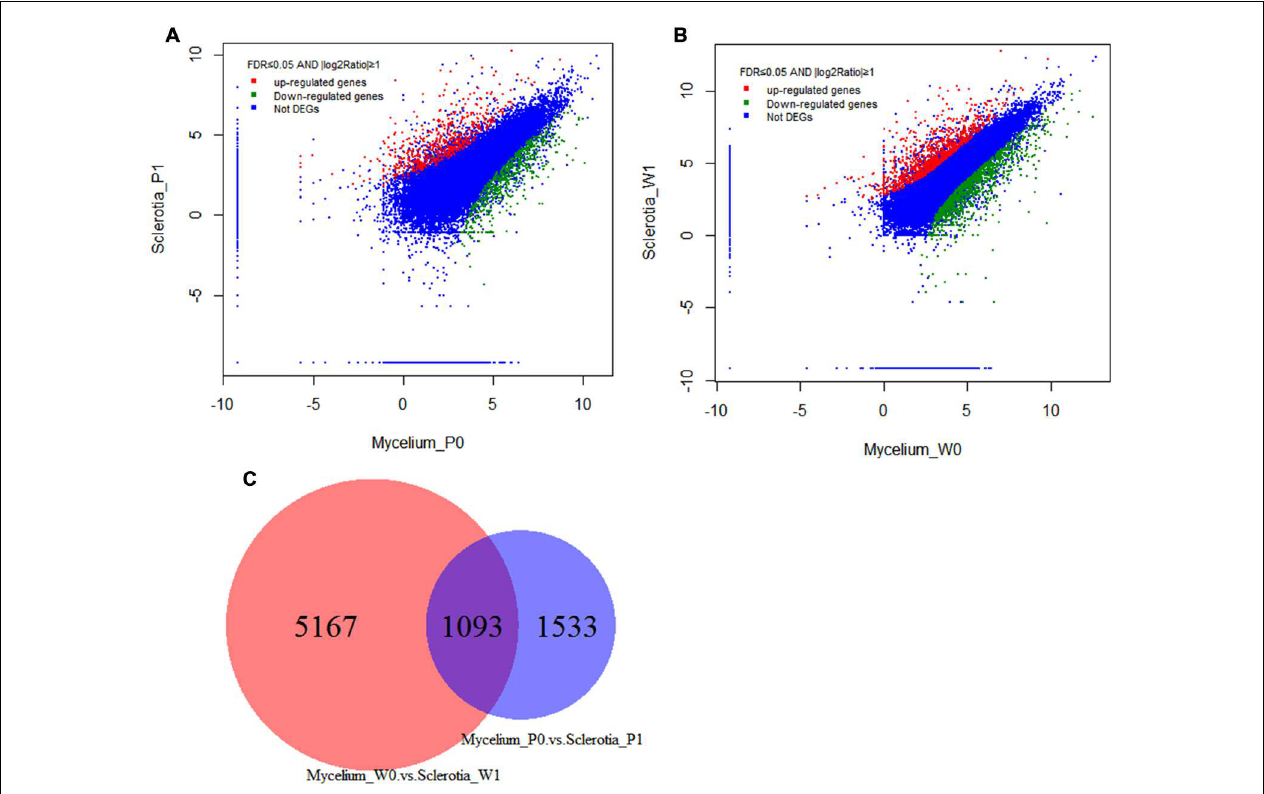
FIGURE 5 | Gene transcription profile between mycelium and sclerotial stages. Scatter plot of total unigenes from the W. cocos transcriptome. The data was normalized as RPKM values and represented on a log 10 scale. Red areas represent up-regulated unigenes in sclerotia, green areas represent down-regulated unigenes in the sclerotia and the blue areas represent no significant expression difference unigenes between mycelium and sclerotia. (A) Sclerotia_P1 and Mycelium_P0 were from the data set sequence in this project. (B) Sclerotia_W1 and Mycelium_W0 were from Shu et al. (2013). (C) Differentially expressed unigenes in both data